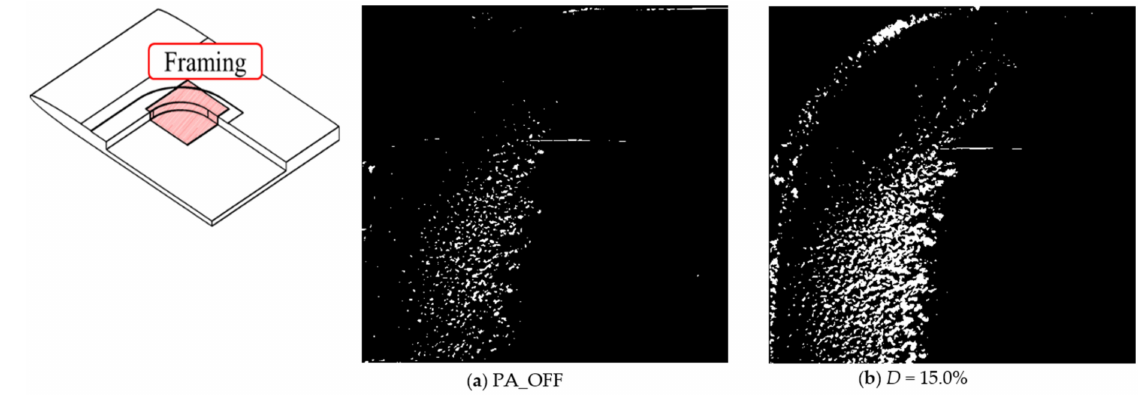
Figure 28. Snow accumulation test (arc model) [First